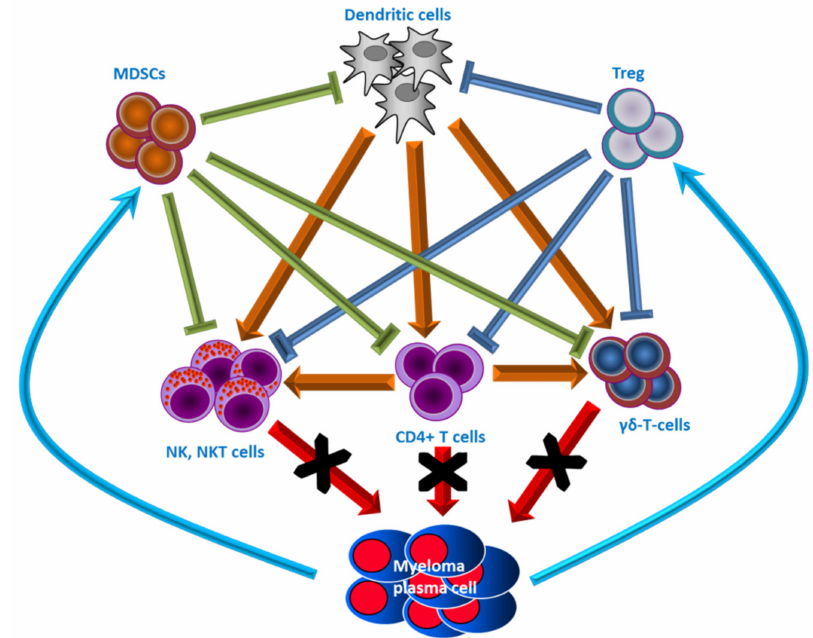
Figure 3. Schematic of functional interactions of immune cells and with malignant plasma cells. The anti-myeloma activity of T cells, natural killer cells (NK), natural killer T cells (NKT), and γδ T cells against MM plasma cells is inhibited by malignant plasma cells via the activation of T regulatory cells (Tregs) and stimulation of myeloid-derived suppressor cells (MDSCs). Moreover, dendritic cell activity is also inhibited by Tregs and MDSCs. This makes the microenvironment immunologically permissive towards myelomatous proliferation and induces MM plasma cell escape from immune surveillance. In the MM pathologic BM, there is an imbalance of T lymphocyte subsets that play a relevant role in MM progression